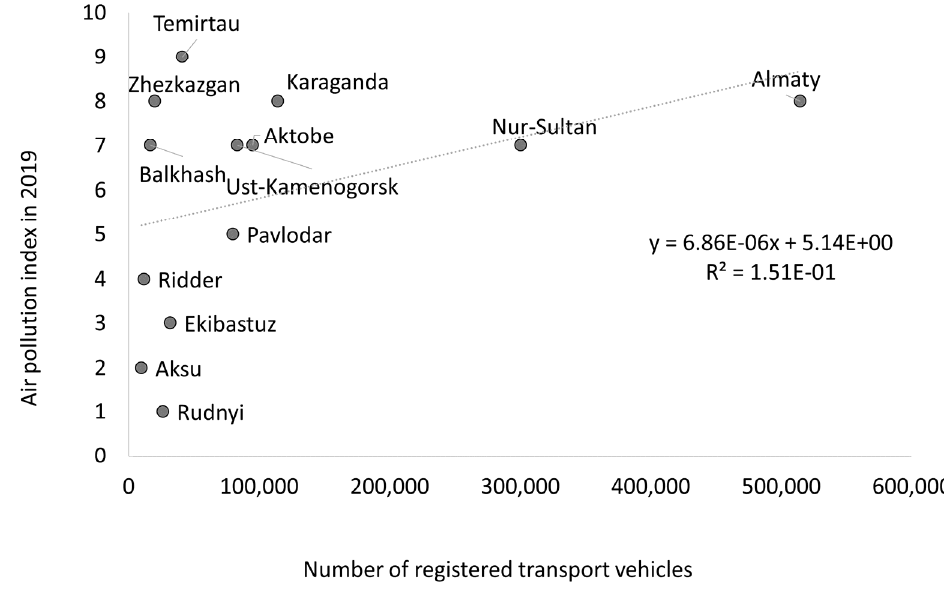
Figure 6. Number of registered vehicles by cities and API in 2019.